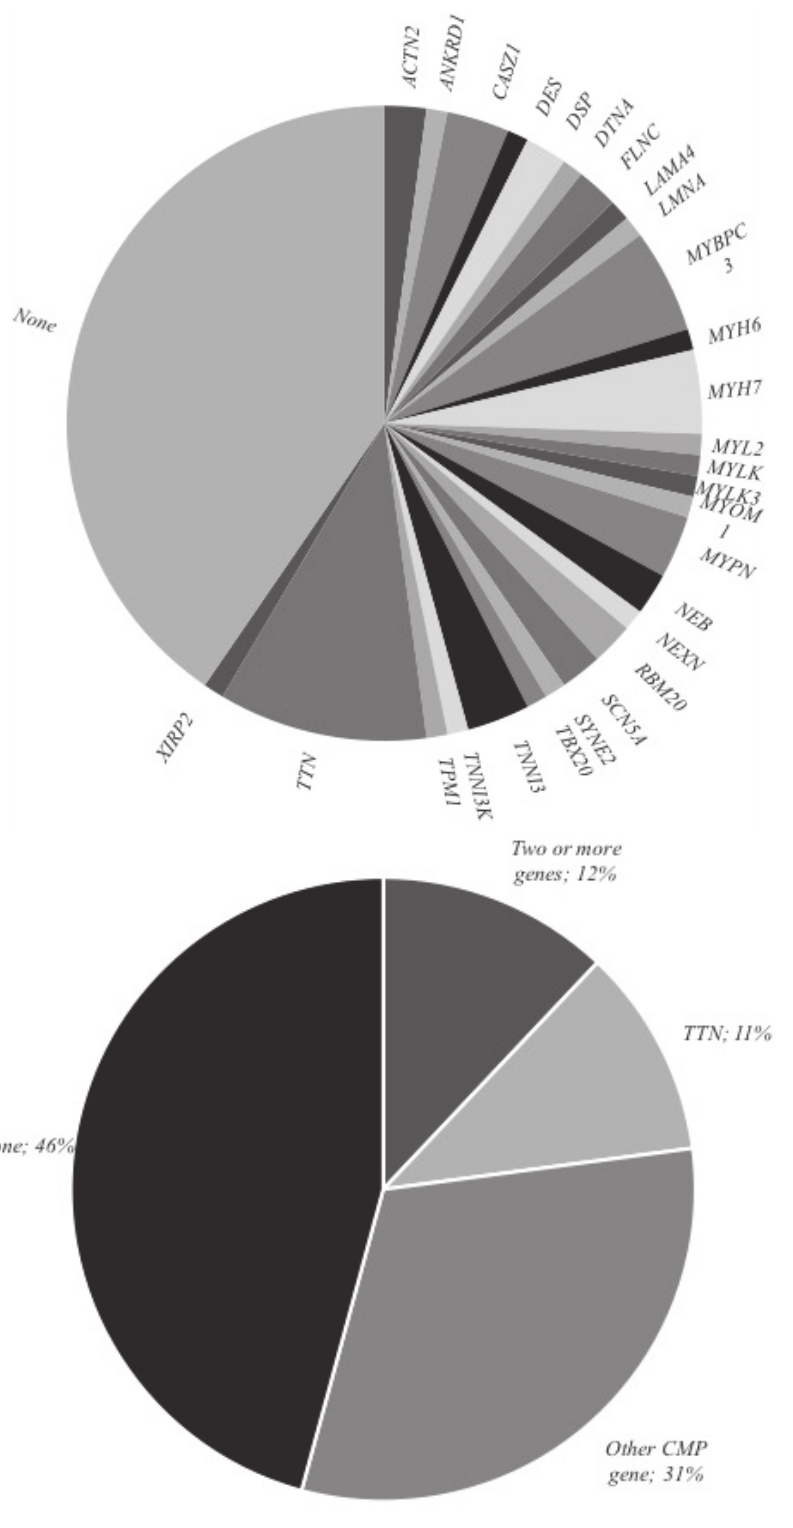
Fig. 1. A, B. Gene distribution in